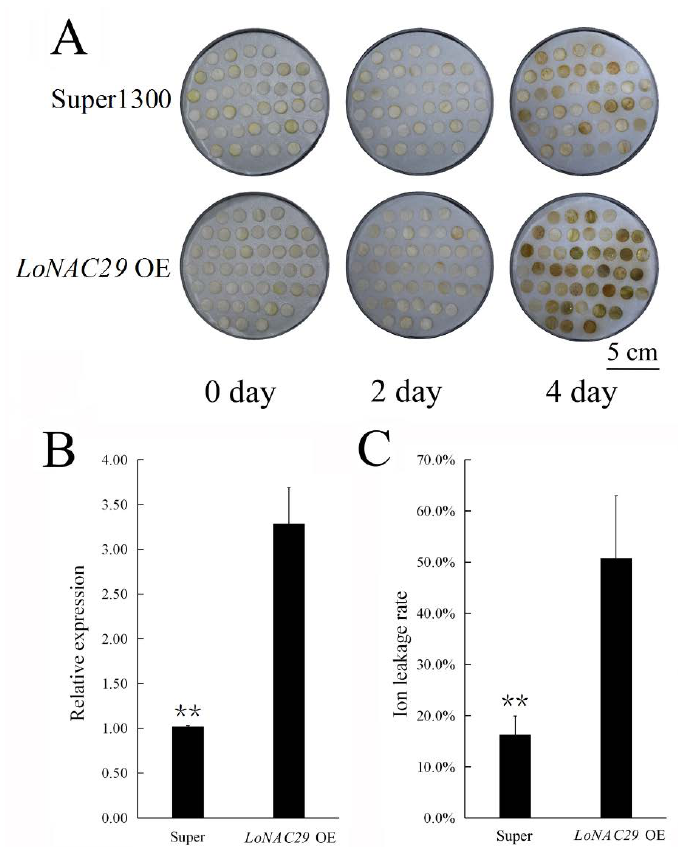
Figure 7. Overexpression of Lilium oriental NAC29 ( LoNAC29 ) in tepal discs of lily ( L. oriental ‘Siberia’). ( A ) Phenotype of LoNAC29 OE and super vector control samples. ( B , C ) Expression of LoNAC29 and ion leakage rate in LoNAC29 OE and super control samples. The data represent the mean ± SE of three biological replicates. ** p < 0.01 (Student’s t -test).